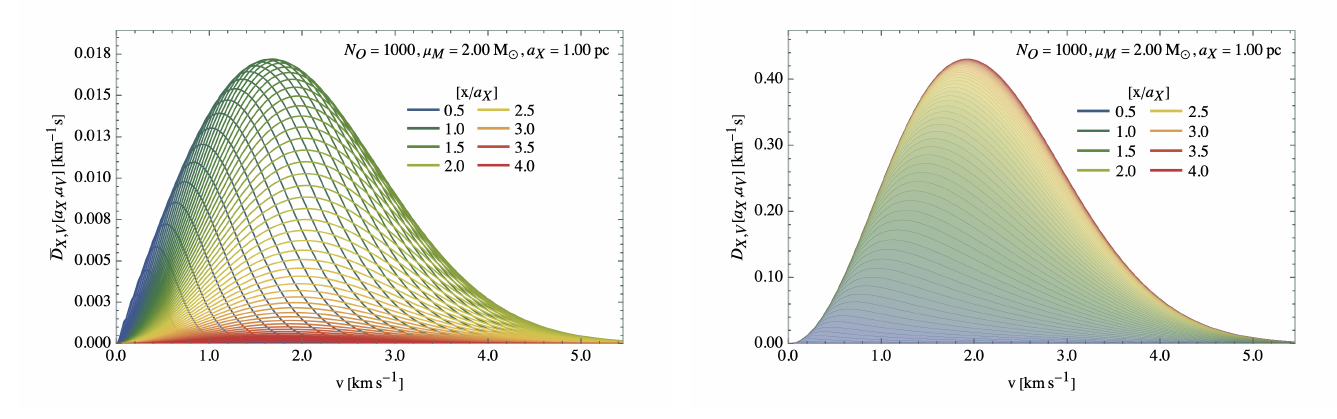
Figure 5. Velocity IC shell-by shell (left) and integrated distributions (right) computed from from Table 1 distributions, at 64 linearly spaced radial bins in the range 0 ≤ x ≤ 4 σ x . The latter is obtained by integration of the shell-specific Maxwell– Boltzmann velocity distribution with a density kernel corresponding to the bin surface area dS = 4 π x 2 , from x = 0 to x = 8 σ . Both the core and the outskirts of the PBH cluster are roughly understood as the regions with 0 ≤ x ≤ a x and 2 a x ≤ x ≤ 4 a x , respectively, and are not heavily populated; the core exhibits very low velocities in the range v ∈ ( 0.0,1.0 ) km/s, while the outskirts exhibits intermediate velocities in the range v ∈ ( 1.0,3.0 ) km/s, whereas the populated intermediate bins do show the largest velocities in the range v ∈ ( 1.0,5.0 )